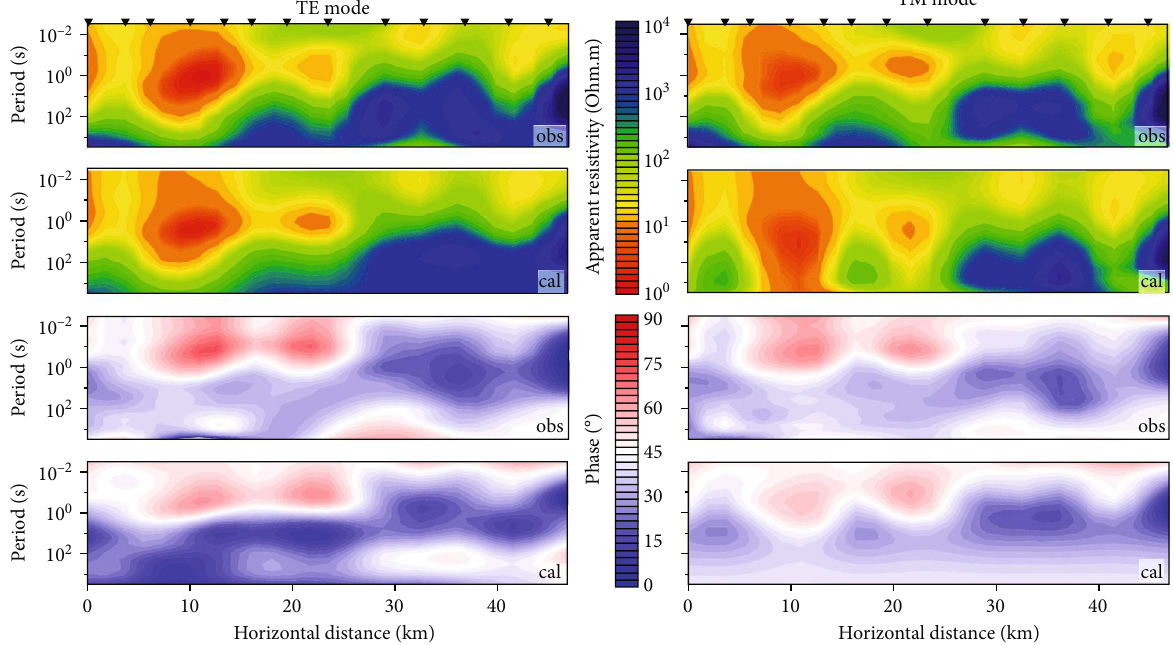
Figure 10: Apparent resistivity and phase pseudosection of MT model for line D-D ′ (central line); observed (obs) and calculated